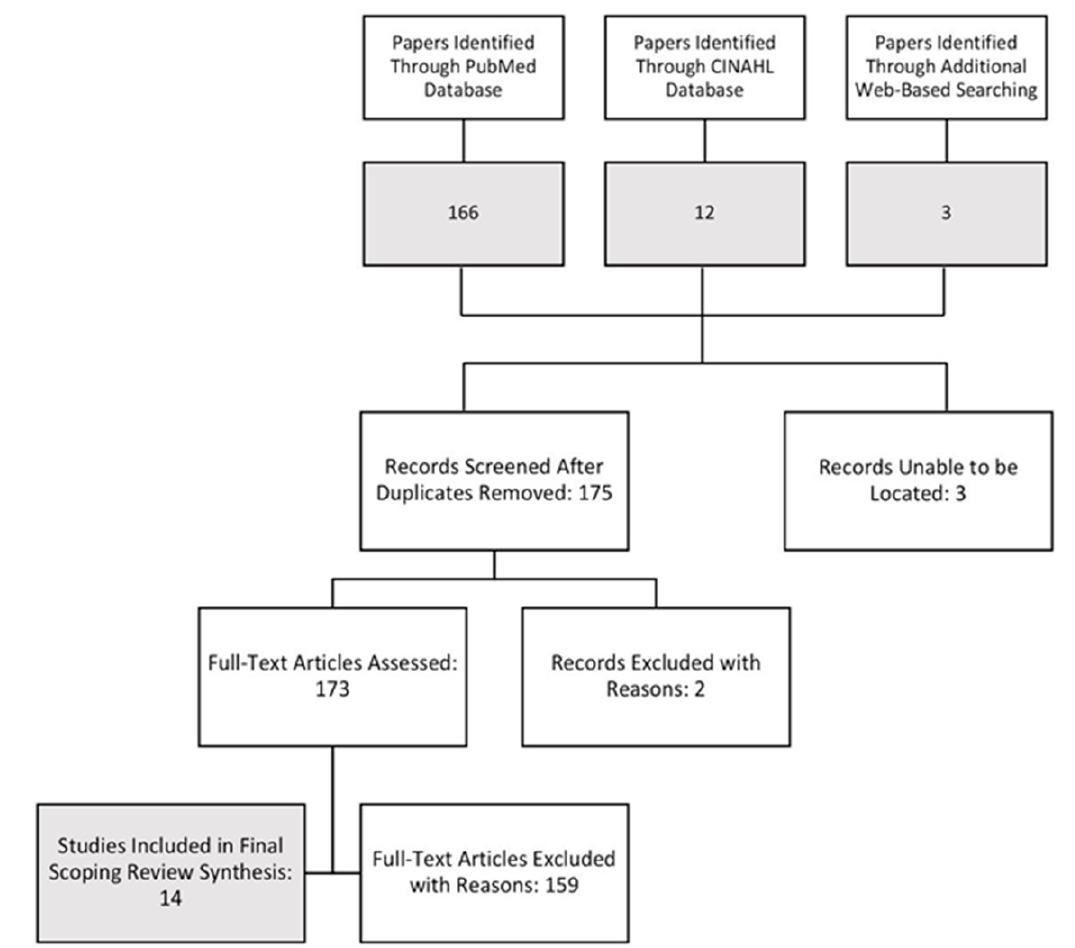
Figure 1. Flow diagram of records assessed for eligibility.